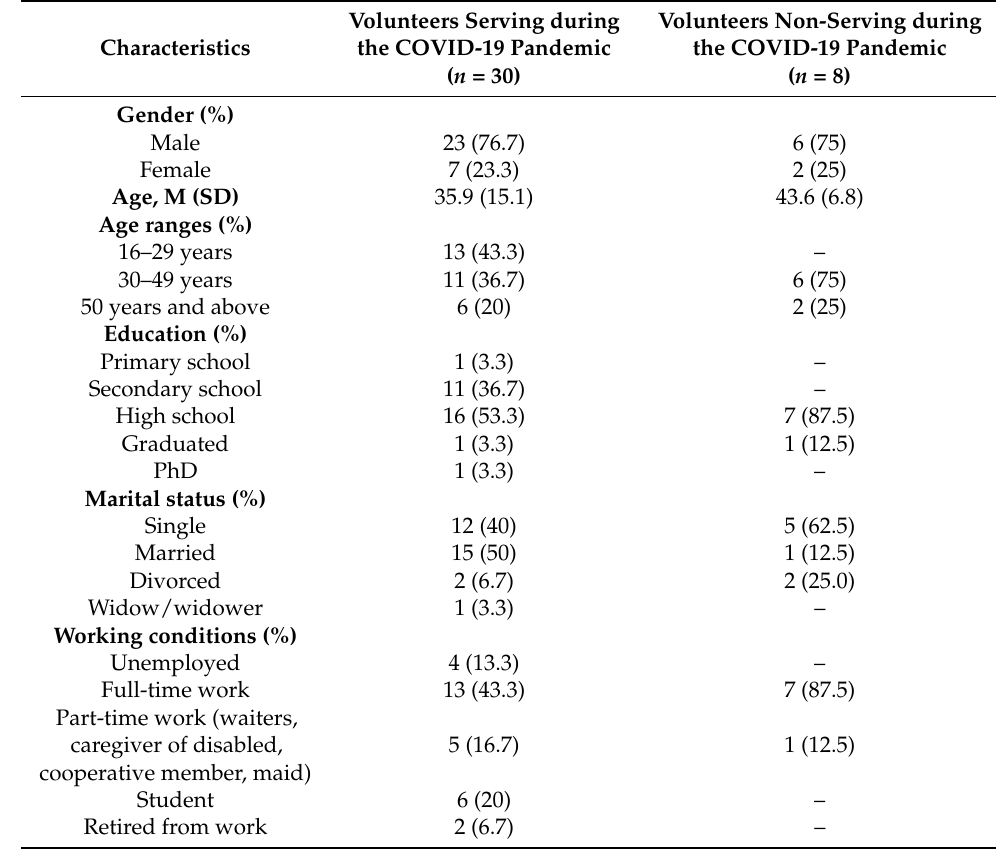
Table 2. Socio-demographic characteristics of the sample.